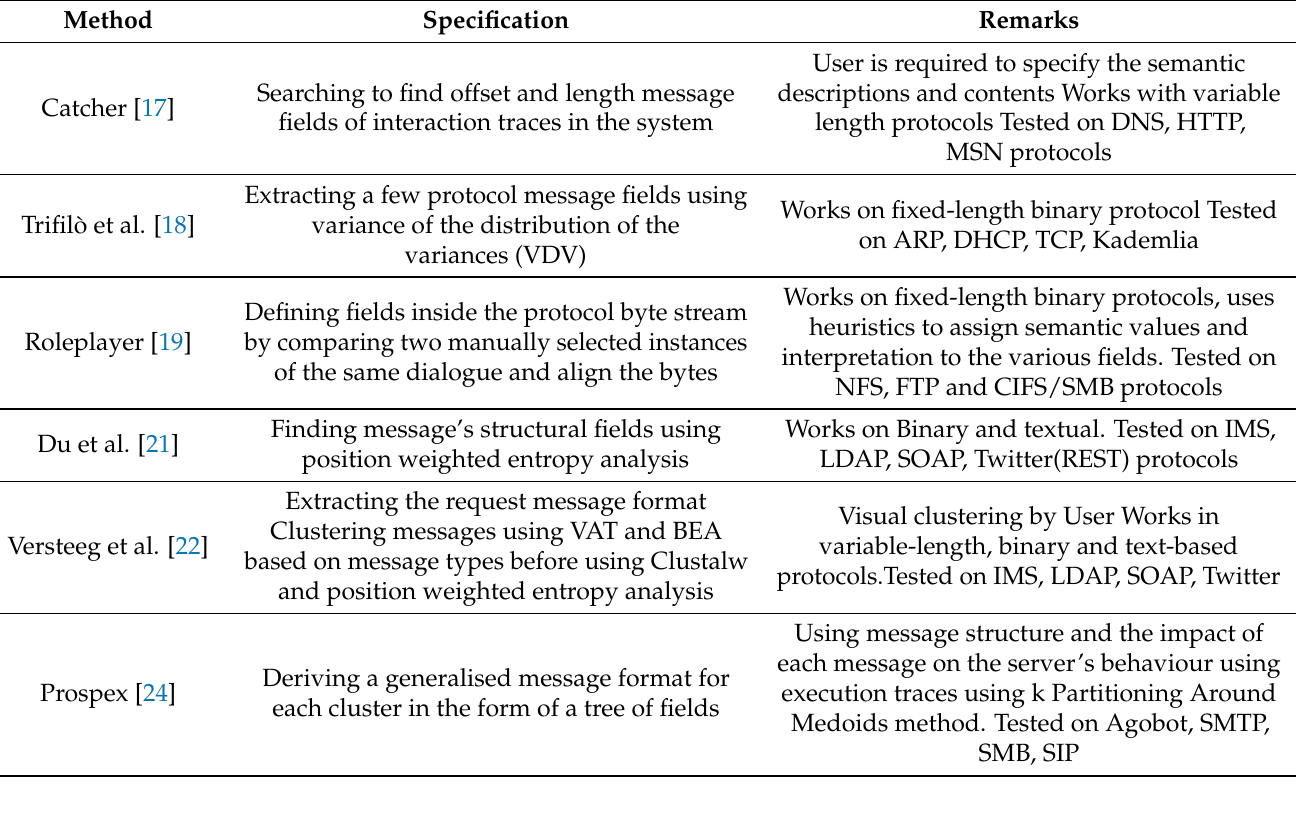
Table 1. Different approaches of partial message format